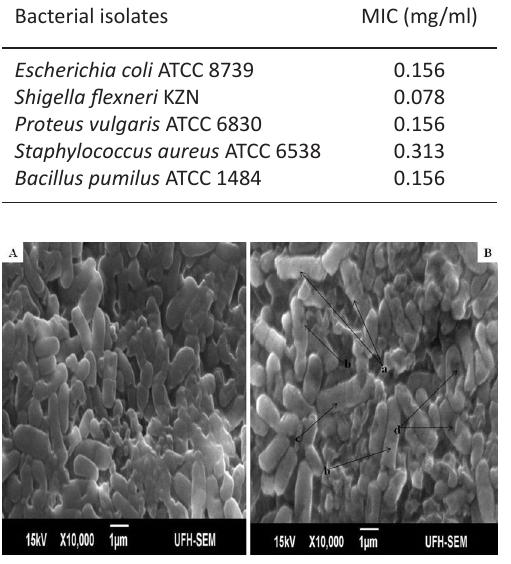
Fig. 1. Influence of ethanol extract on the morphology of E. coli . A = Extract untreated E. coli ; B = Extract treated E. coli . (a = dead cells with rough surfaces; b = collapsed and elongated dead cells; c = bulged or swollen dead cells; d = depressions in dead cells).